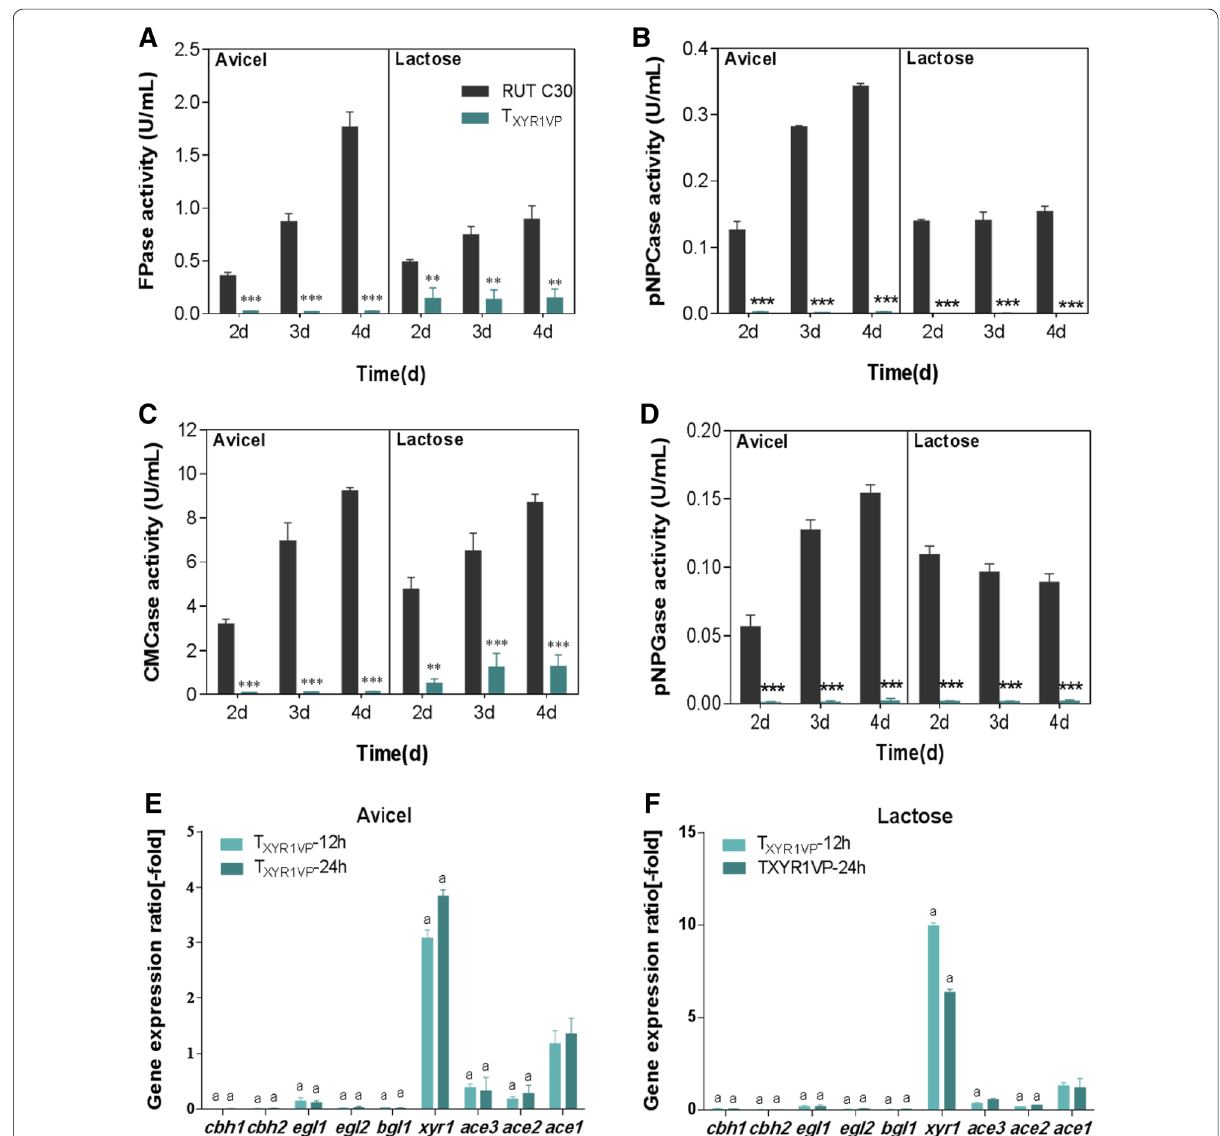
Fig. 3 Cellulase production and a comparison of transcript levels of cellulase-related genes between strains T XYR1VP and RUT C30. FPase ( A ), p NPCase ( B ), CMCase ( C ), and p NPGase ( D ) activities of RUT C30 and T XYR1VP after a switch from glycerol to 20 g/L Avicel or lactose. Enzymatic activities were measured at 2, 3, and 4 days after the transfer. Error bars show the respective standard deviations of three biological replicates; asterisks indicate significant differences (* P 0.05; ** P 0.01; *** P 0.001; n.s. not significant) between the transformants and RUT C30, as assessed ≤ ≤ ≤ by Student’s t test. Expression ratios of cellulase-related genes on 20 g/L Avicel ( E ) or lactose ( F ) for 12 and 24 h after the switch from glycerol. Data on T XYR1VP transformants were normalized to the corresponding gene expression levels at the same time points in RUT C30. Values represent the mean of three biological replicates, and the error bars denote standard deviations. Gene expression ratios greater than twofold or less than 0.5-fold are marked with